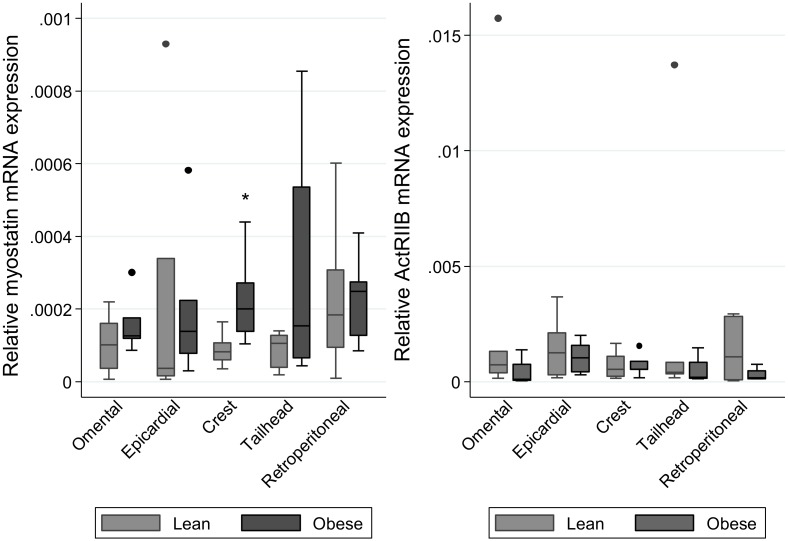
Gene expression of Myostatin and ActRIIB in adipose tissues of lean and obese horses and ponies.Gene expression was analysed by real-time PCR and the geometric mean of the two most stable housekeeping genes as determined by GeNorm (RPL32 and beta-actin) was used for normalisation. Relative transcript abundance is shown for Myostatin (A) and ActRIIB (B). *denotes where values differ significantly (p<0.05) from lean group. n = 6/group.